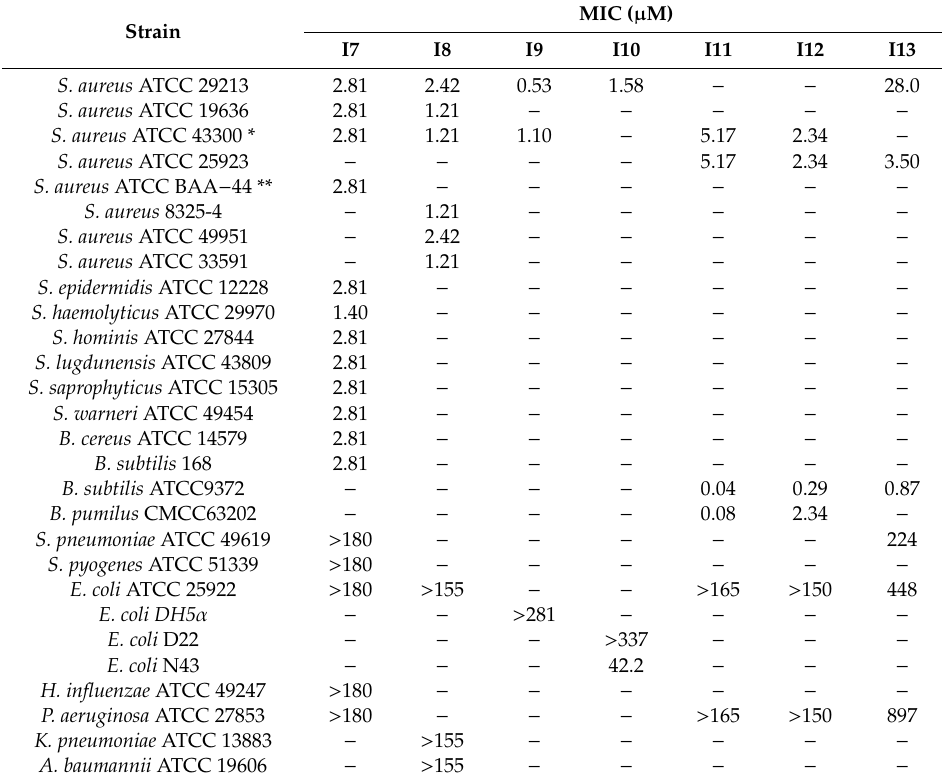
Table 7. MICs of benzamides